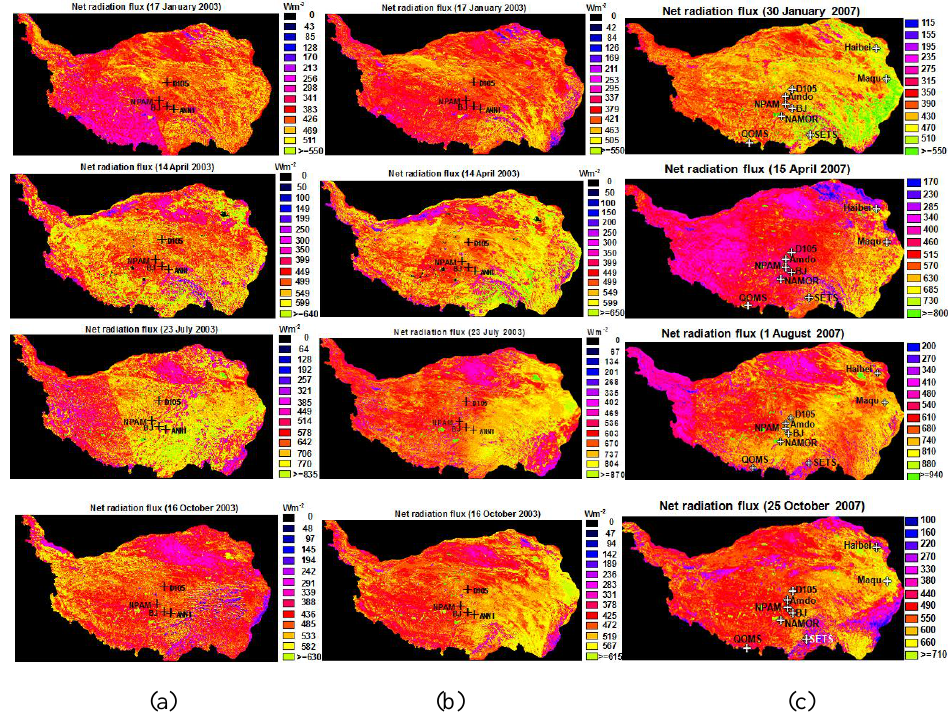
Fig. 2. The distribution maps of net radiation flux over the Tibetan Plateau area (73.5–107.1 ◦ E, 25.0–40.1 ◦ N). (a) AVHRR-2003; (b) MODIS-2003; (c) MODIS-2007. Fig.2 The distribution maps of net radiation flux over the Tibetan Plateau area